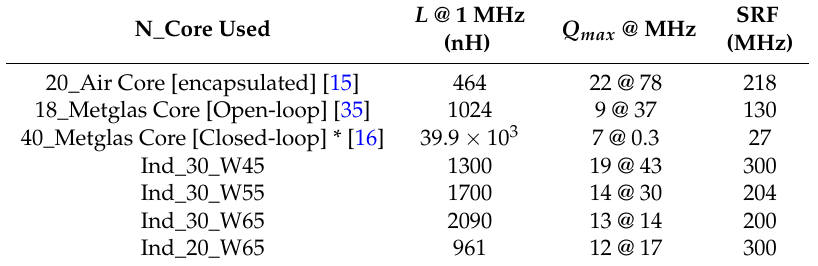
Table 4. Comparison between the inductance achieved in this work and the previous